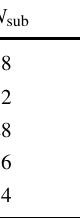
scription we give the dimension N sub of S , i.e. the number of S ij , and then the of linearly independent eigenvectors e α i